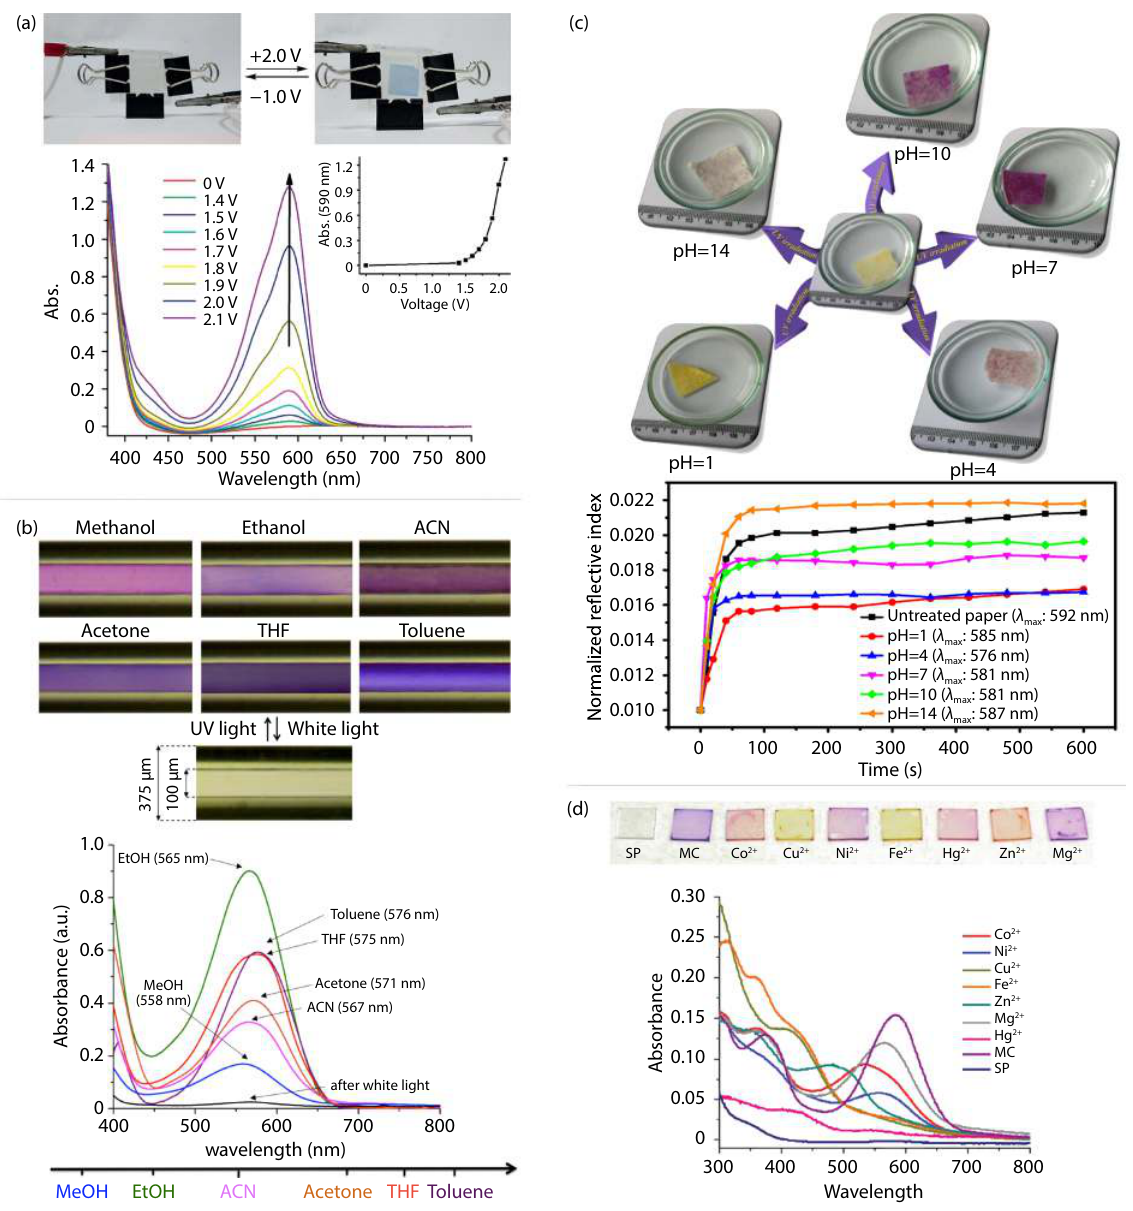
Fig. 10 Some stimuli-chromic phenomena of smart materials based on photochromic compounds. ( a ) Real objects illustration of the electrochromism for an oxazine derivative and its UV/Vis absorption spectra in THF (reprinted with permission from ref. [166], © 2014 WILEY‐VCH Verlag GmbH & Co. KGaA, Wein- heim). ( b ) Pictures of the solvatochromic microcapillary when irradiated with UV light while different solvents are passed through the microcapillary in continuous flow and after irradiation with white light (reprinted with permission from ref. [168], © 2013 American Chemical Society). ( c ) Color changes of the prepared stimuli- responsive paper in various pHs under UV irradiation at 365 nm, and normalized reflective index at the corresponding λ max for the untreated paper and the treated ones in different pHs (reprinted with permission from ref. [169], © 2018 Elsevier). ( d ) UV-Vis spectra in the presence of different metal ions of reversible colorimetric ion sensors based on surface-initiated polymerization of photochromic polymers (reprinted with permission from ref. [170], © 2008 The Royal Society of